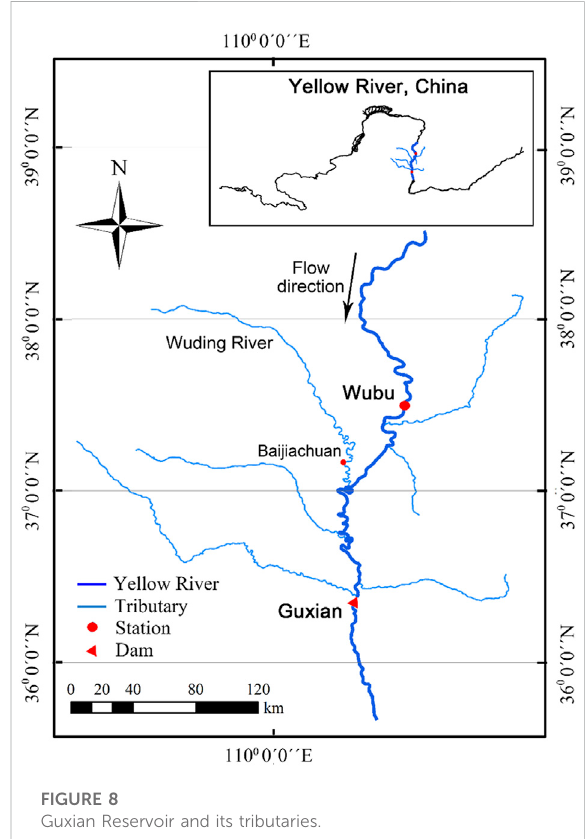
FIGURE 8 Guxian Reservoir and its